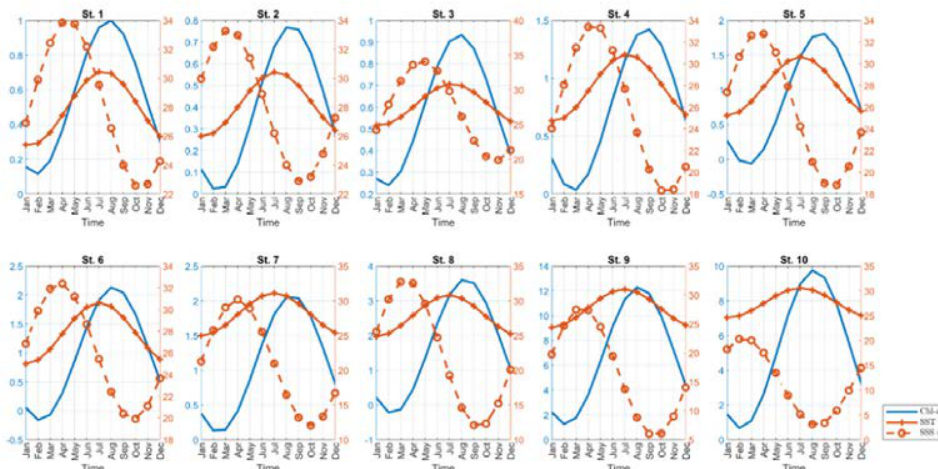
Fig. 4: Seasonal model of Chlorophyll-a (Chl-a) (solid line with blue color, in ), Sea Surface Temperature (SST) (solid brown line with a plus symbol, in o C), and Sea Surface Salinity (SSS) (dashed brown line with empty bullets, in psu), with 10 sample station (St. 1-10). The position of the axis values of each graph corresponds to the color of the graph, namely the left ordinate for Chl-a (blue color) and the right ordinate for SST and SSS (brown color).